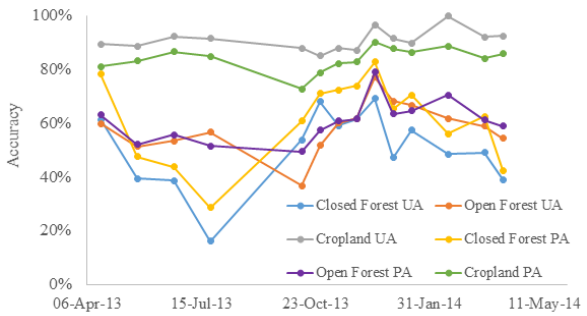
Figure 4. User’s accuracy and producer’s accuracy for different land cover